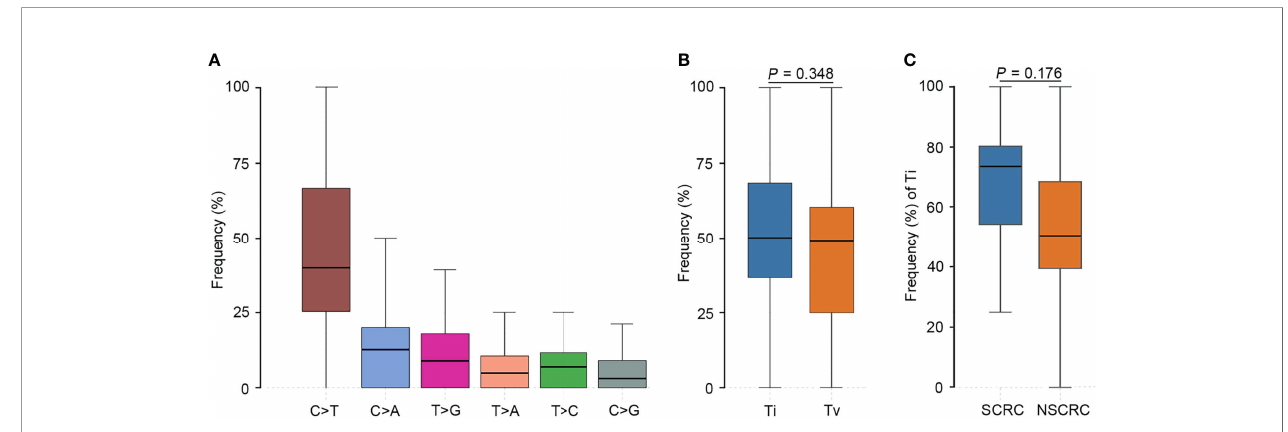
FIGURE 5 | Comparison of the pro fi les of transition (Ti) and transversion (Tv) between SCRC and NSCRC patients. (A) The bar plot shows each type of Ti or Tv in NSCRC. (B) Comparison between Ti and Tv ratios in NSCRC. (C) Comparison of Ti ratios between the SCRC and NSCRC groups.